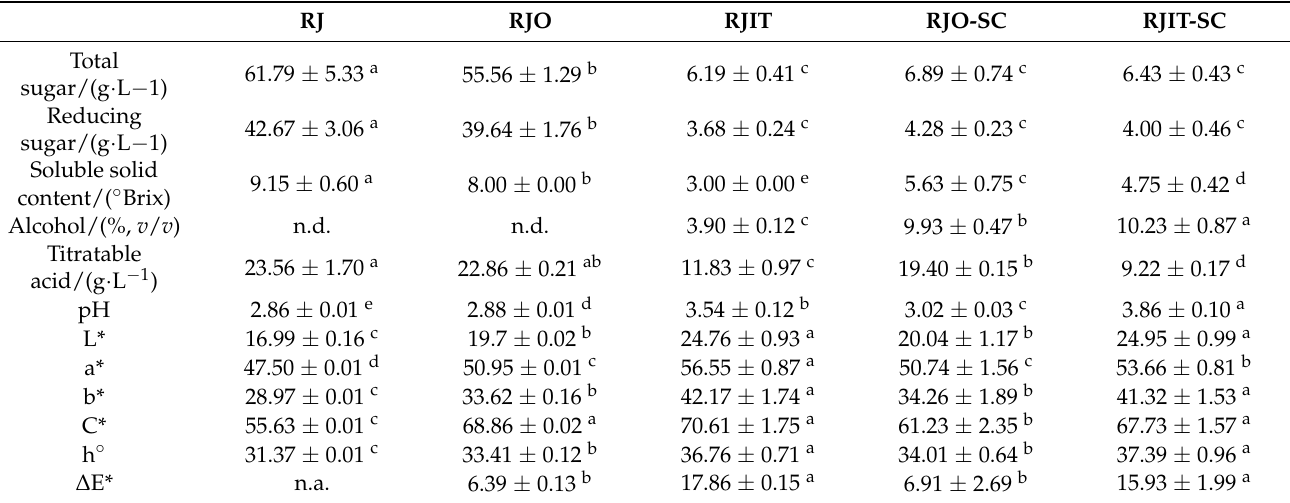
Table 1. Effect of I. terricola WJL-G4 on physicochemical properties of red raspberry wines. RJ